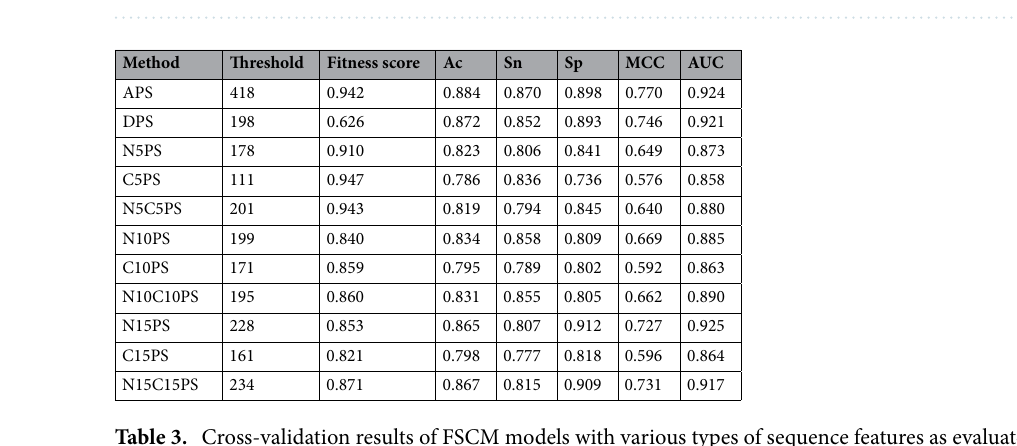
Figure 3. ROC curves of top-five types of propensity scores over tenfold cross-validation ( A , C ) and independent test ( B , D ) on main ( A , B ) and ( C , D ) alternative dataset.